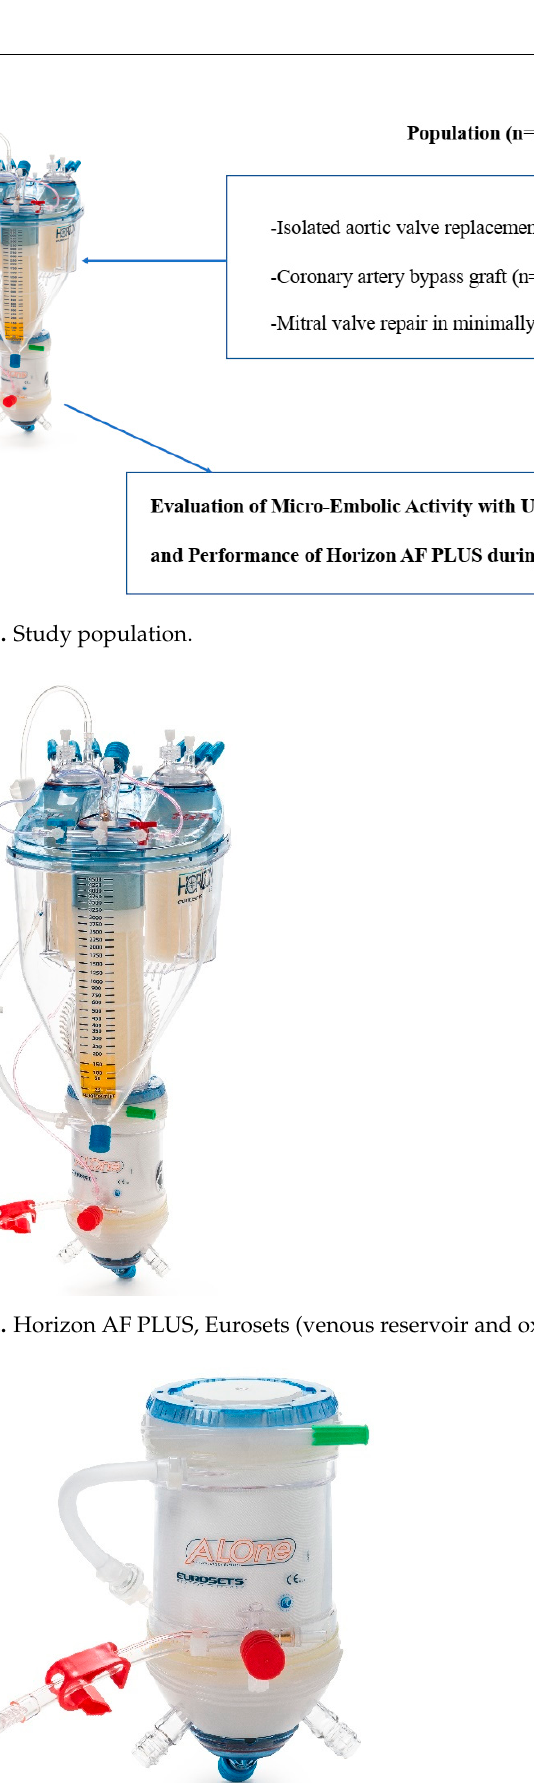
Figure 3. A.L.ONE AF PLUS